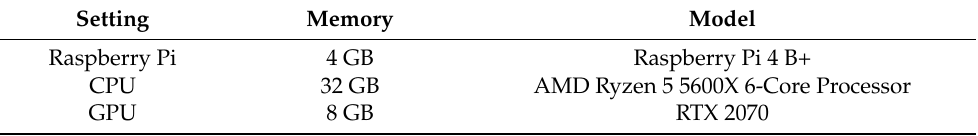
Table 8. The hardware specification of each setting. Setting